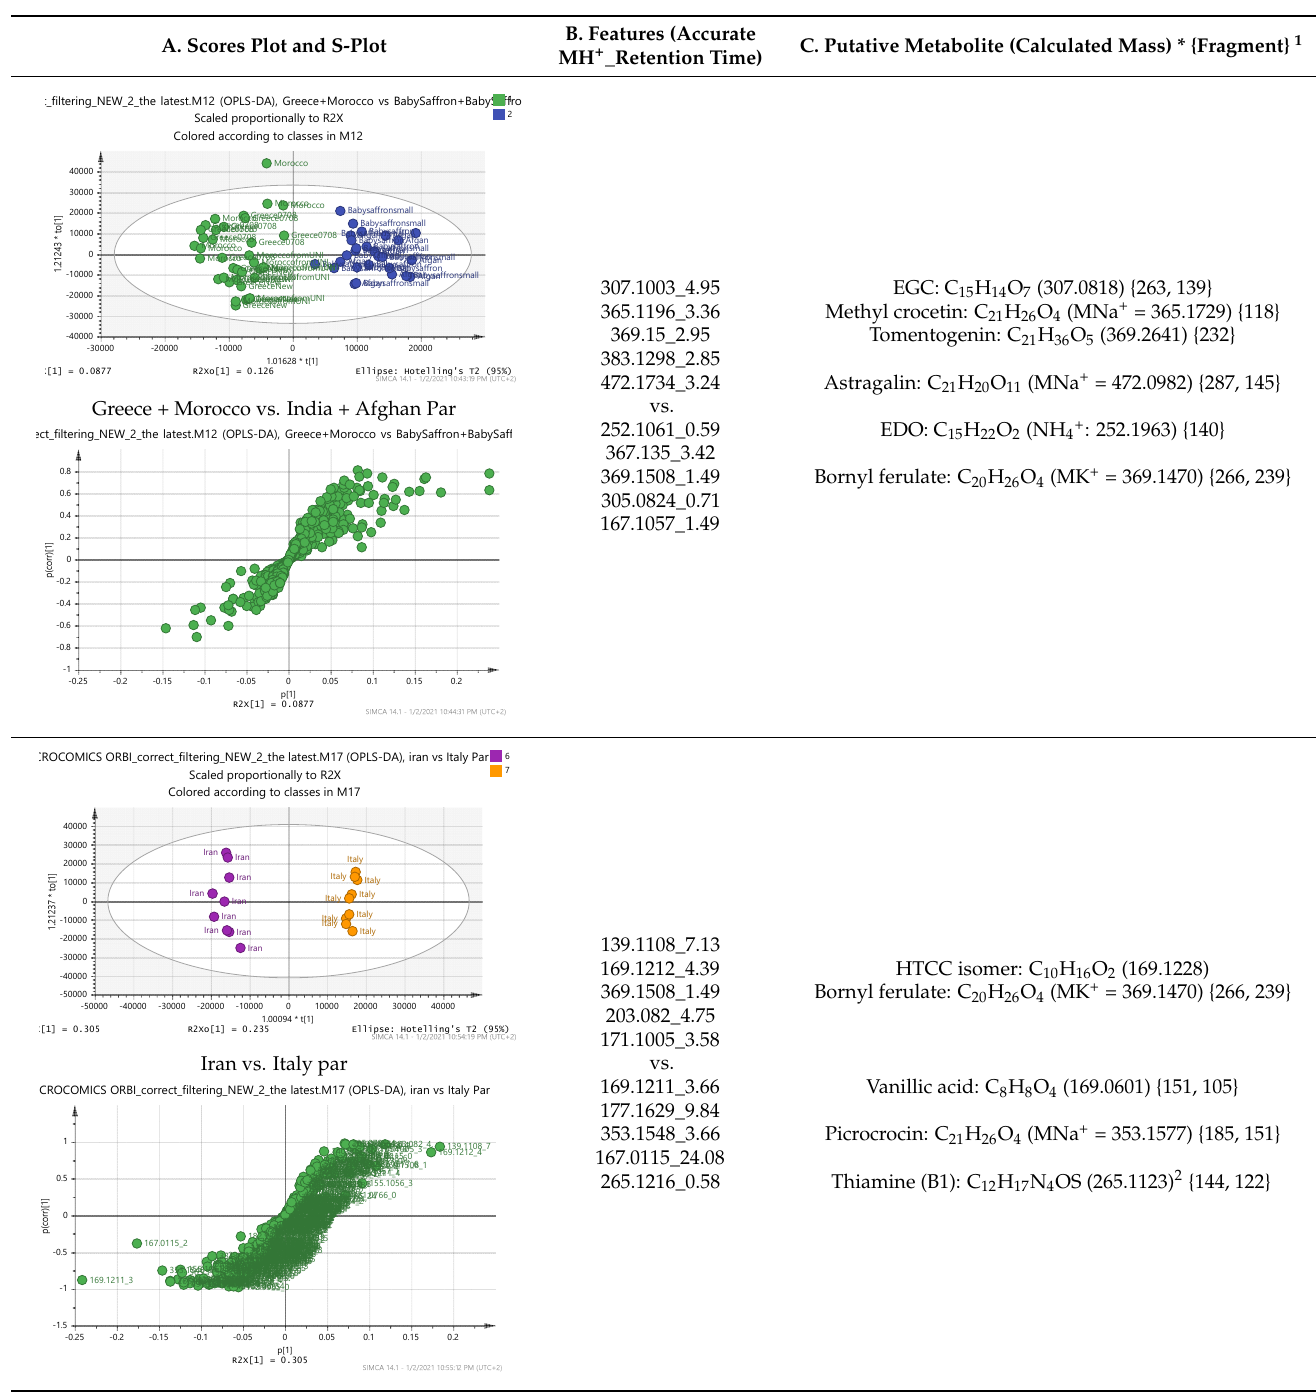
Table 1. Cumulative table of the A. Multivariate statistics B. Identifying discriminating features and C. Putative metabolite annotation with the calculated protonated molecular ion (MH + ) or the adduct ion mass signals shown in parenthesis, whereas the fragment ions are denoted in curly brackets.